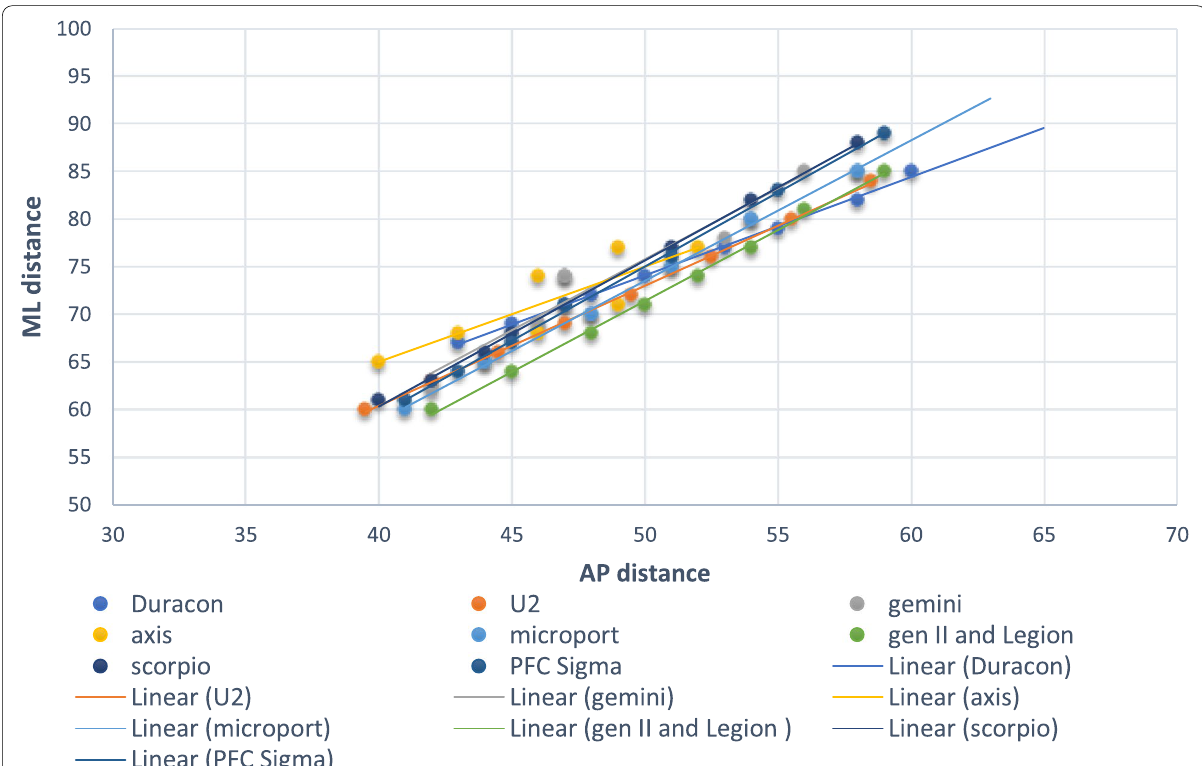
Fig. 4 Anteroposterior and mediolateral dimensions of TKR tibial prostheses in the Philippine and Asian